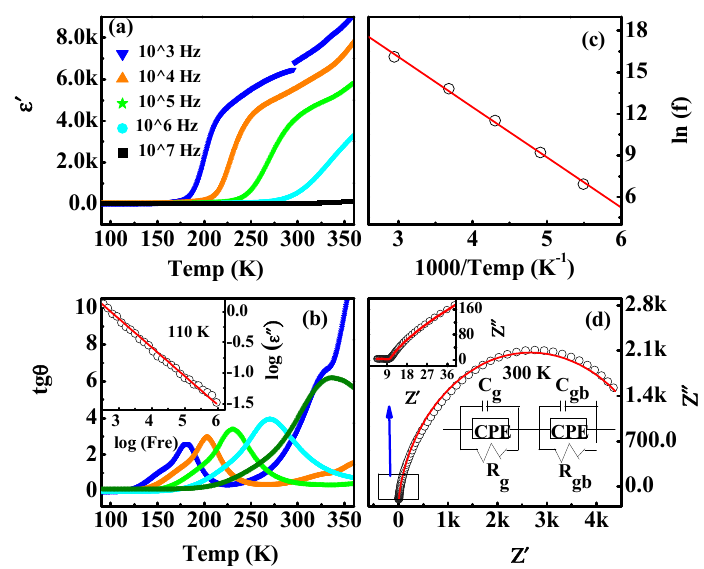
Figure 3. (Color online) ( a ) The real part ( ε′ ) of the dielectric constant vs. temperature at various frequencies. ( b ) Corresponding dielectric loss (tan δ ). The inset is log ( ε″ ) vs. log (f) at 110 K in the low frequency region and the solid line is the one with slope − 1. ( c ) The lnƒ vs. 1000 / T derived from tan δ . ( d ) Nyquist plots at 300 K for the circuit shown.